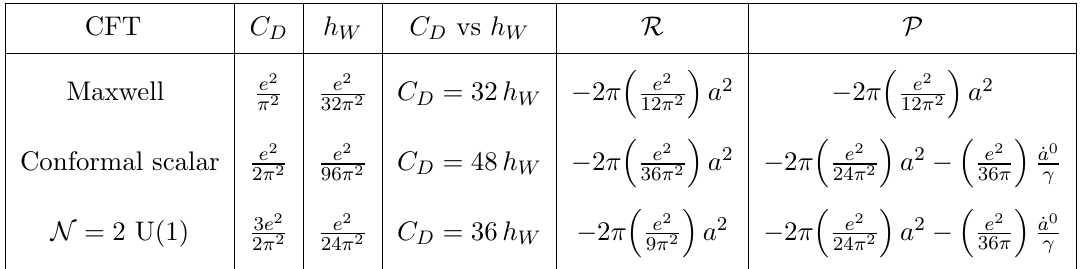
Table 1 . The relevant quantities for three di(cid:11)erent free conformal theories. The (cid:12)rst line refers to the Maxwell theory with Lagrangian L = 1 F 2 , where F is the electro-magnetic (cid:12)eld strength, with 4 (cid:0) (cid:1) R a line operator W = exp i e dx (cid:22) A (cid:22) . The second line refers to a scalar (cid:12)eld (cid:30) with Lagrangian (cid:0) (cid:1) L = 1 @(cid:30) 2 + R (cid:30) 2 where R is the Ricci scalar, with a line operator W = exp 2 6 line refers to = 2 SYM theory described in section 2 with gauge group U(1). Notice that N